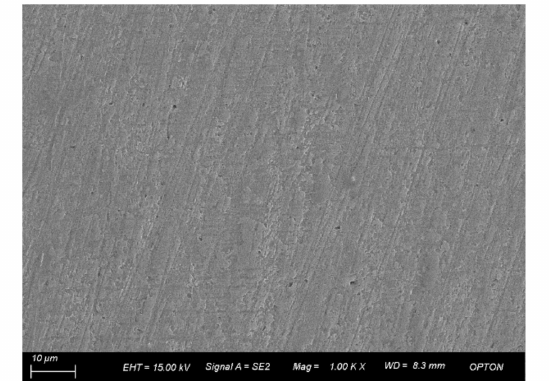
Figure 4. SEM micrographs of the pure magnesium sheet after three